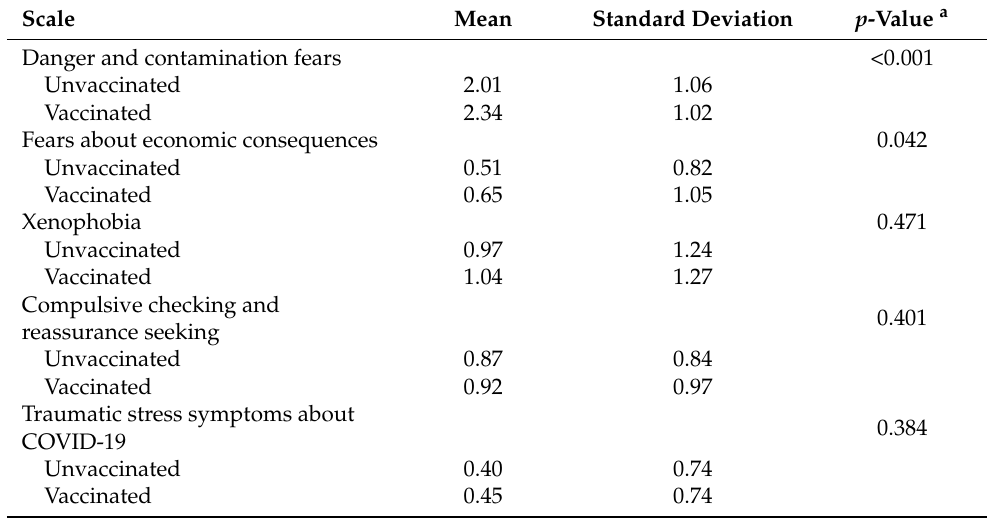
Table 3. COVID-19-related stress of pregnant women according to COVID-19 vaccination status. Scale Mean Standard